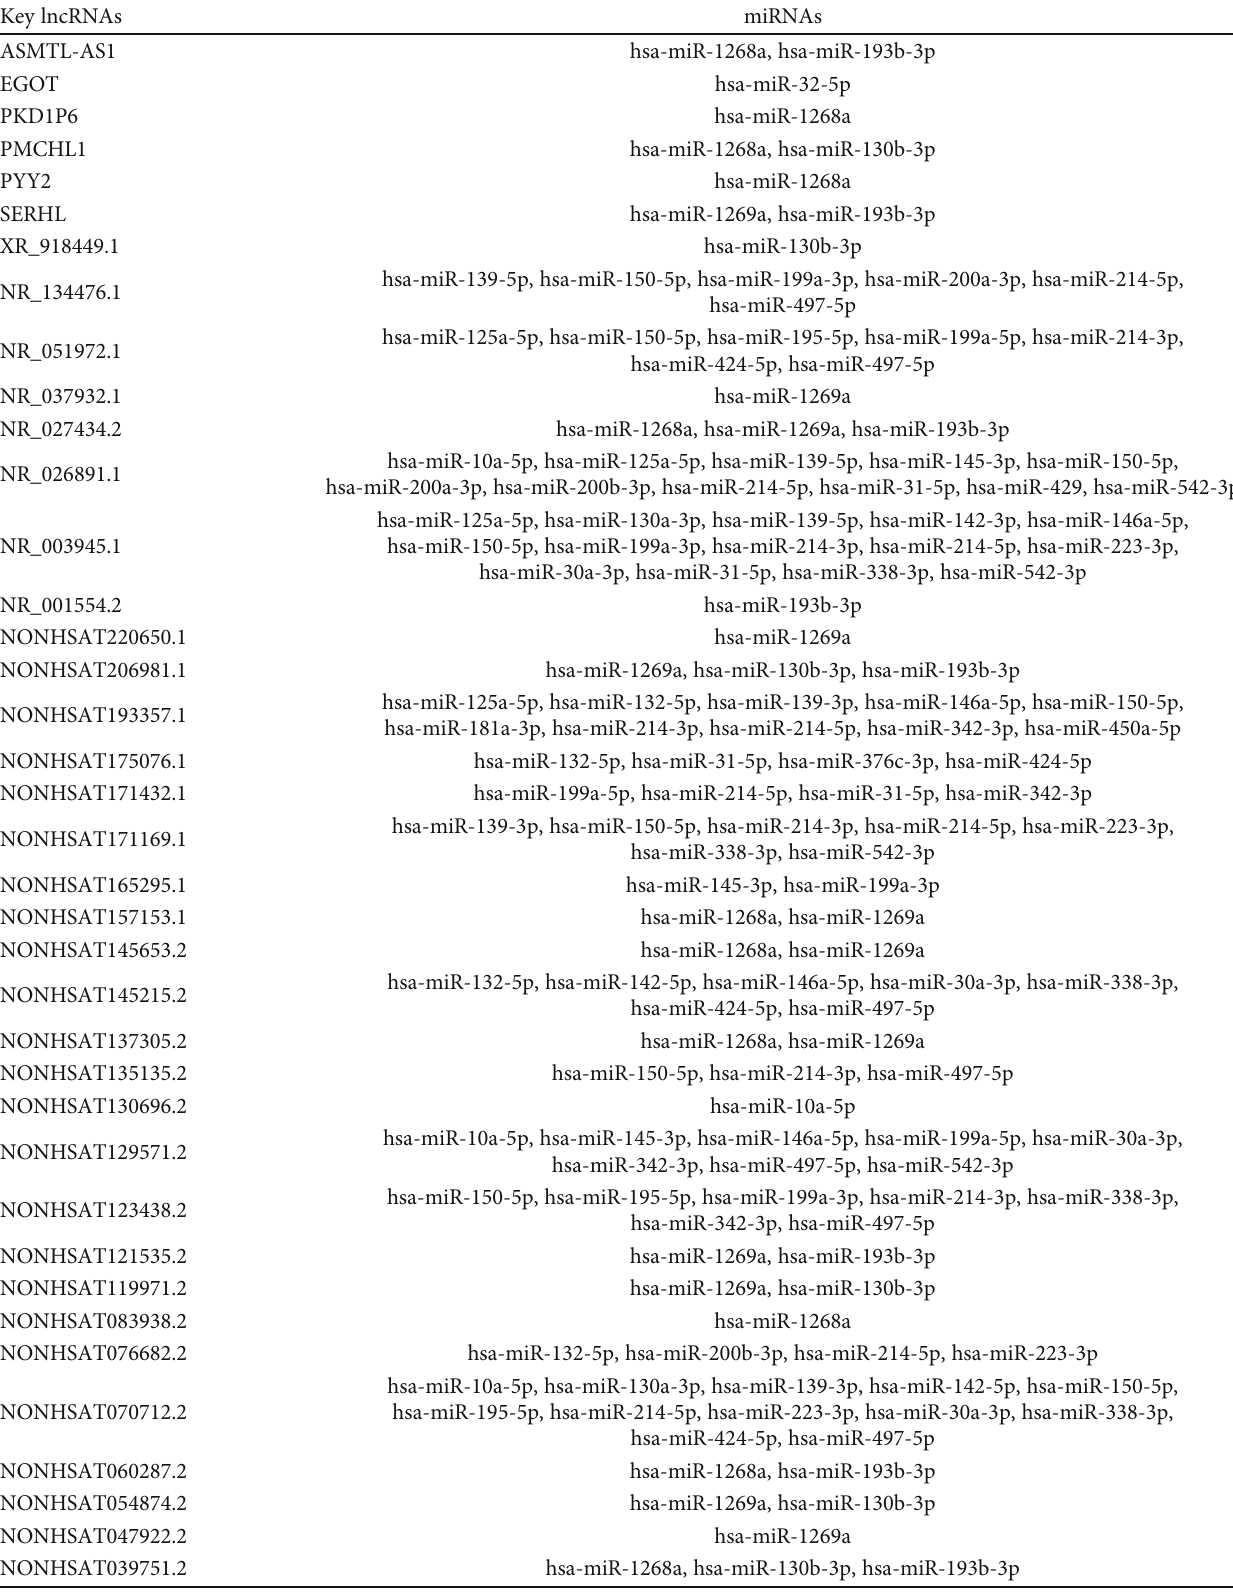
Table 2: miRNAs targeting speci fi c key lncRNAs in cirrhotic